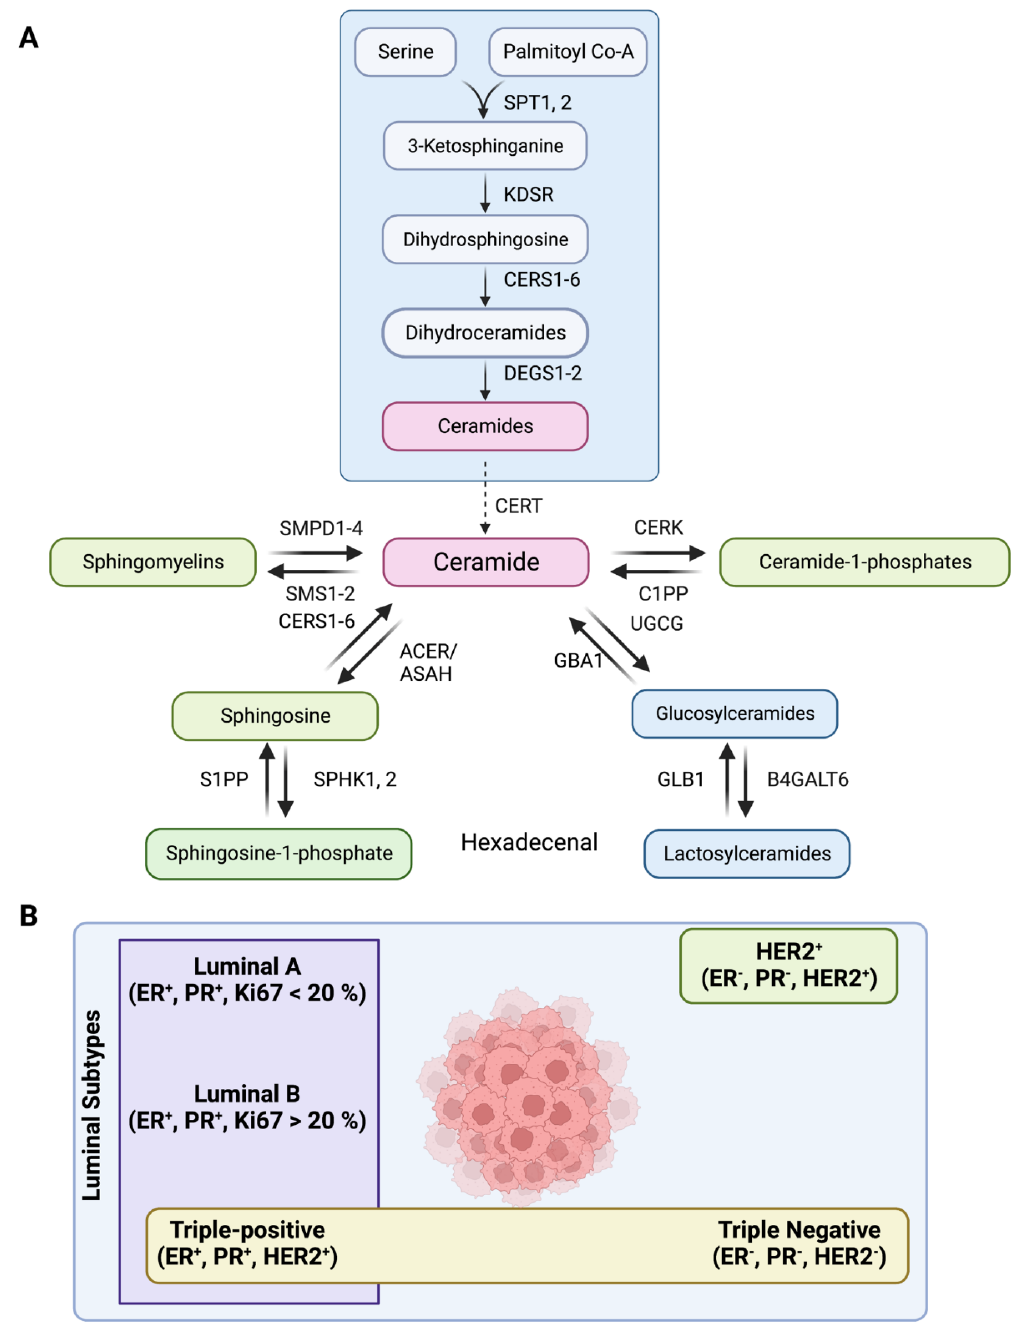
Figure 1. ( A ) Schematic showing the sphingolipid metabolic pathway where serine palmitoyl trans-